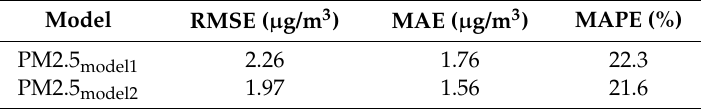
Figure 10. Time series of PM2.5 concentrations with 1 min resolution from the mobile test run in the area of Thessaloniki, Greece on 9 March 2017. The two fitted linear regression models are compared with the readings of the optical particle sizer. Table 1. Error metrics for the mobile run test (without lag